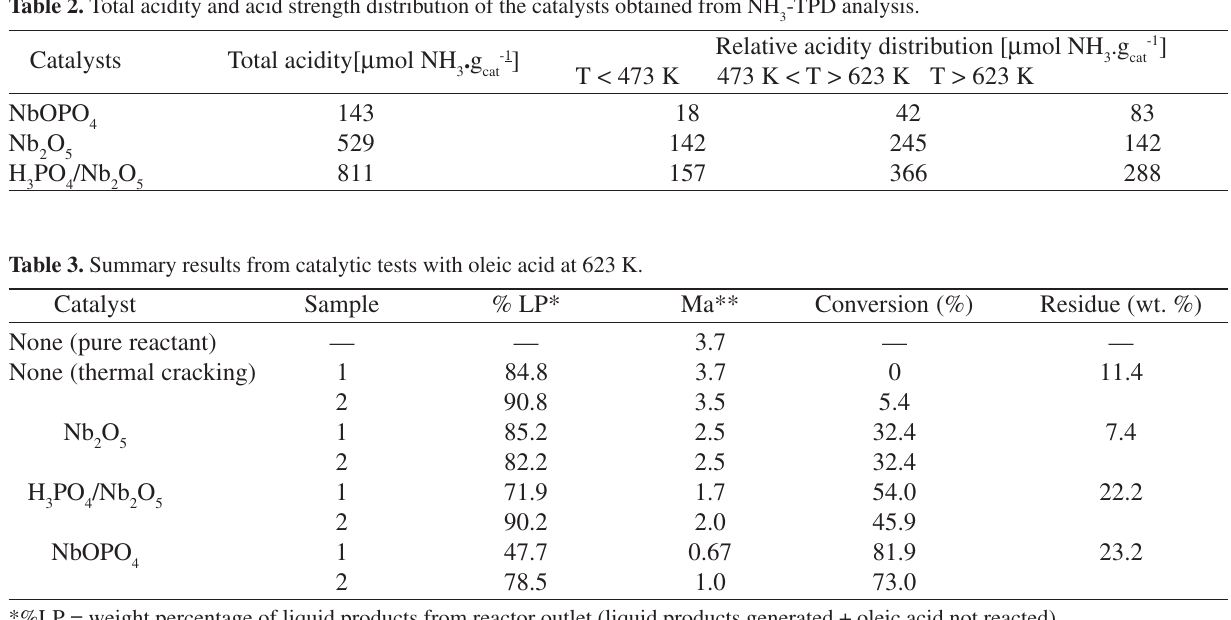
Table 2. Total acidity and acid strength distribution of the catalysts obtained from NH